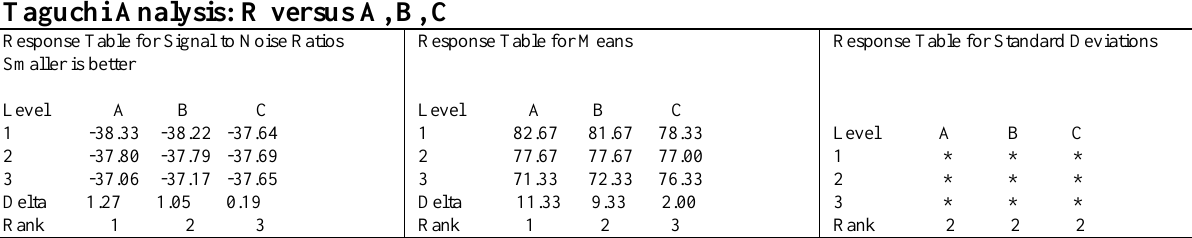
Fig. 9. Results of analysing the achieved data for designed